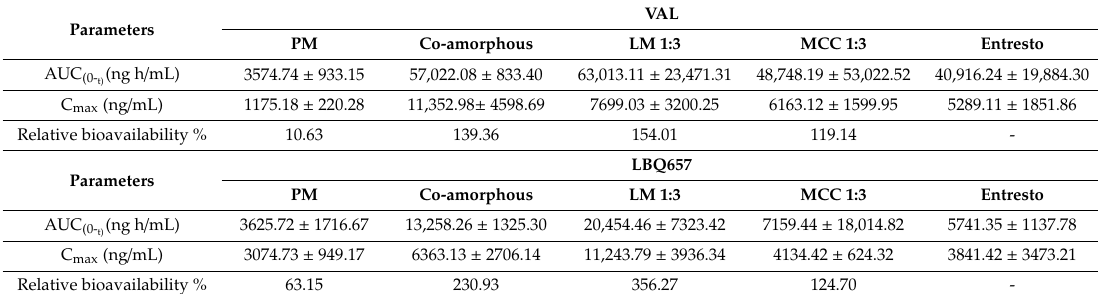
Table 2. Pharmacokinetic data of VAL and LBQ657 ( n = 5, mean ±